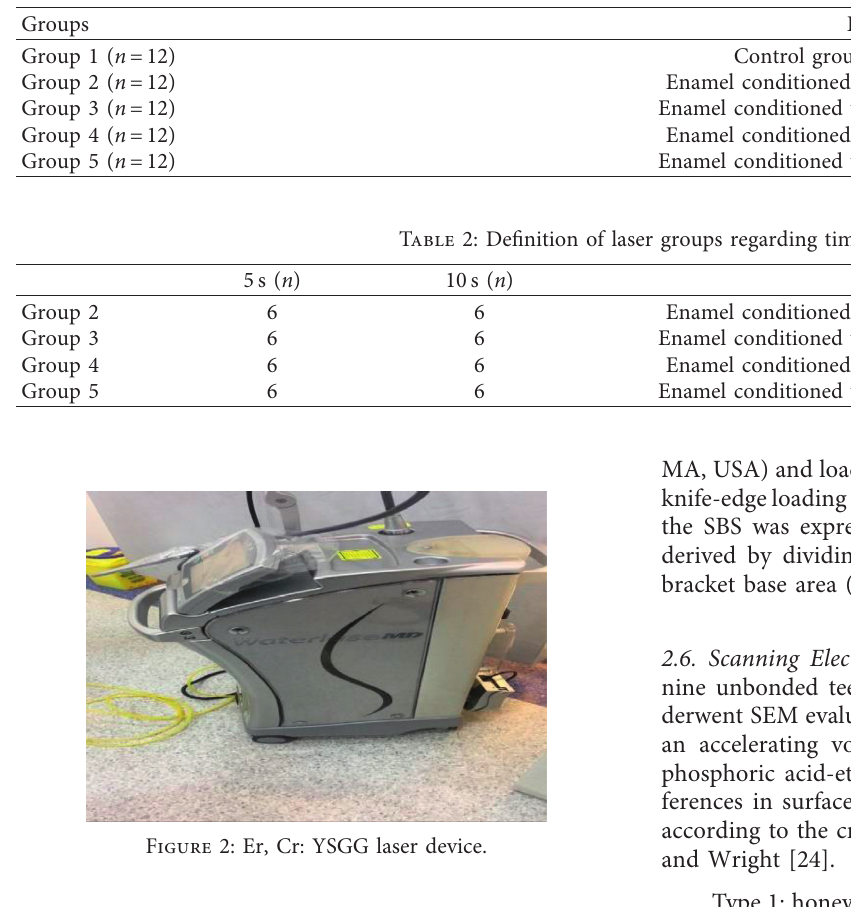
Table 1: Definition of laser groups.